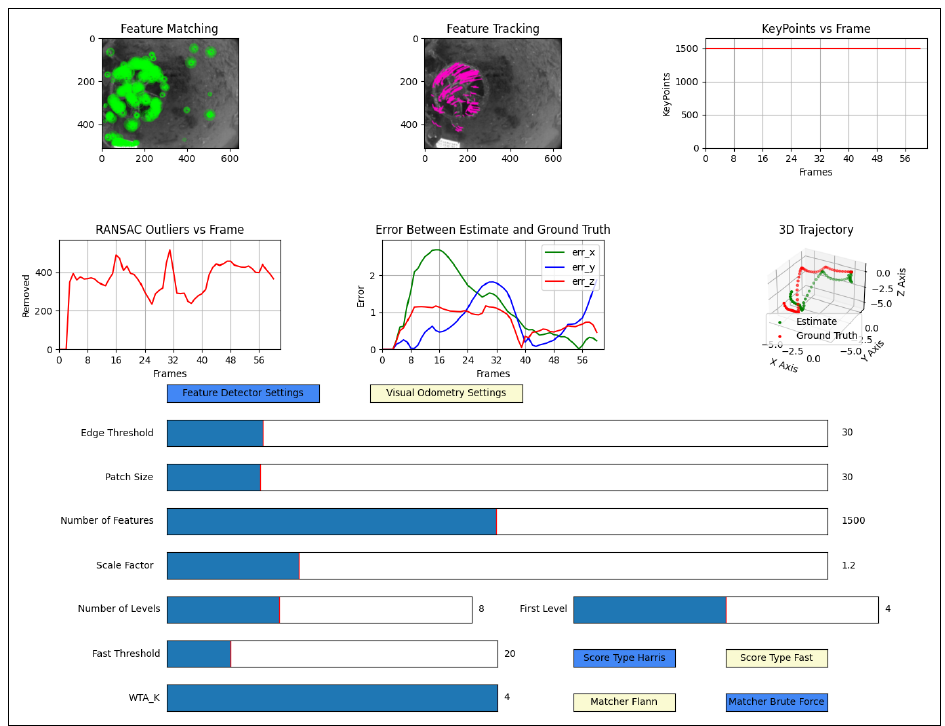
Figure 13. Python Matplotlib GUI showing the statistics of ORB features on the AQUALOC harbor- sequence-02 dataset [42] and including the video feed overlaid with ORB features: “3D Camera Trajectory” on the bottom right showing the structure-from-motion “ground truth” for comparison; “Sliders and Buttons” on the bottom enabling adjustment of ORB and VO settings in